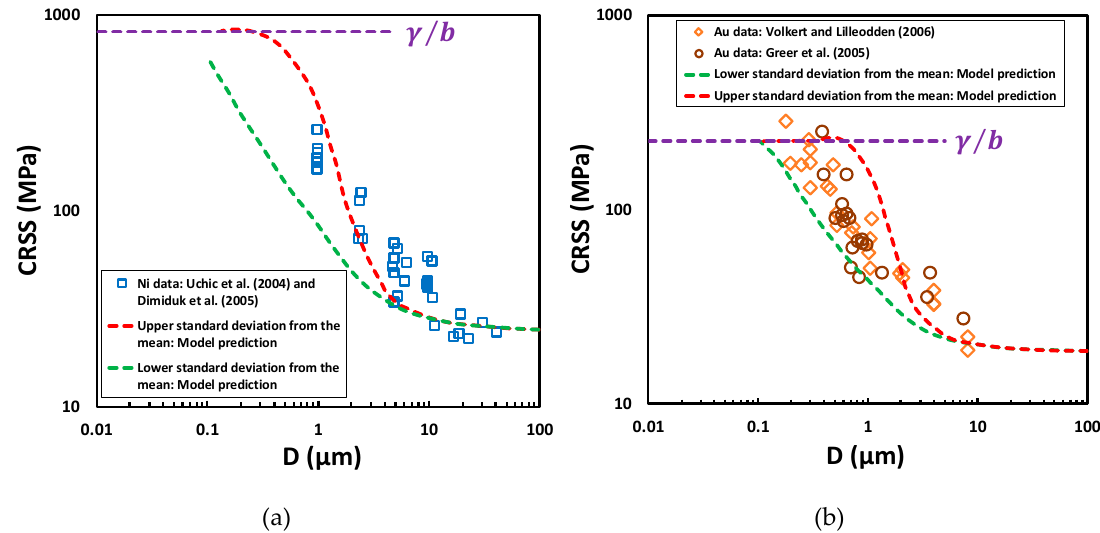
Figure 7. Size effects in pillars with different sizes for: ( a ) Ni; ( b ) Au. The original experimental data has been reported by Uchic et al. [7], Dimiduk et al. [25], Greer et al. [26], and Volkert and Lilleodden [28] (after Parthasarathy et al. [52]).